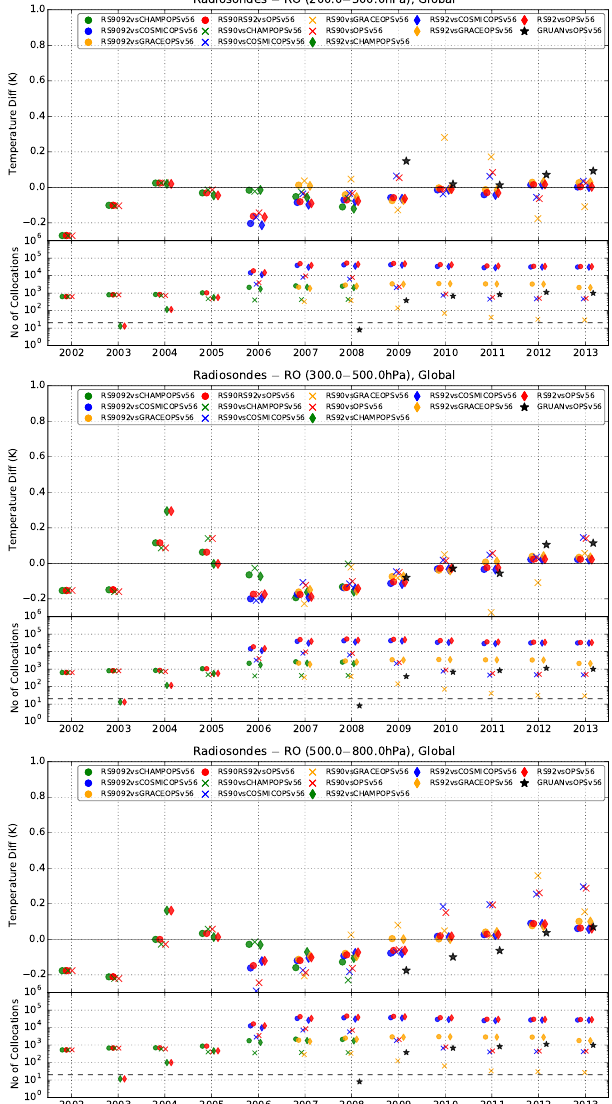
Figure 5. Same layout as Fig. 4 but shown for tropospheric pressure layers 200 to 300hPa (top), 300 to 500hPa (middle), and 500 to 800hPa (bottom),